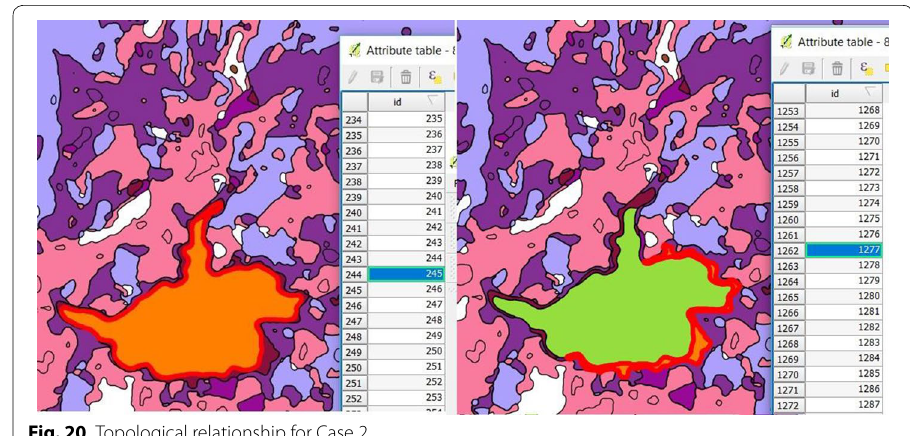
Fig. 20 Topological relationship for Case